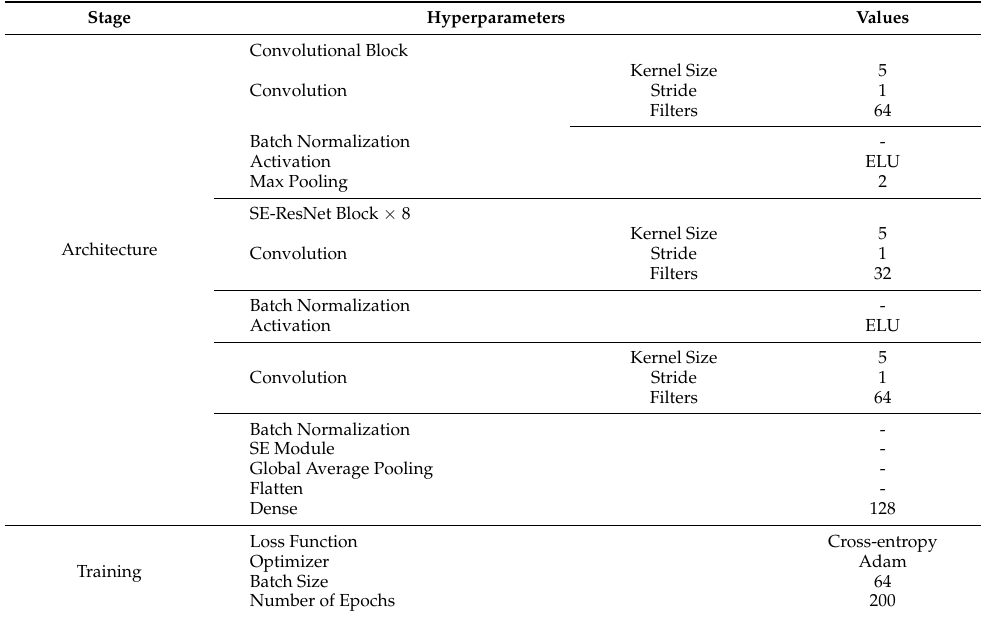
Table A4. The summary of hyperparameters for the 1D-ResNet-SE network used in this